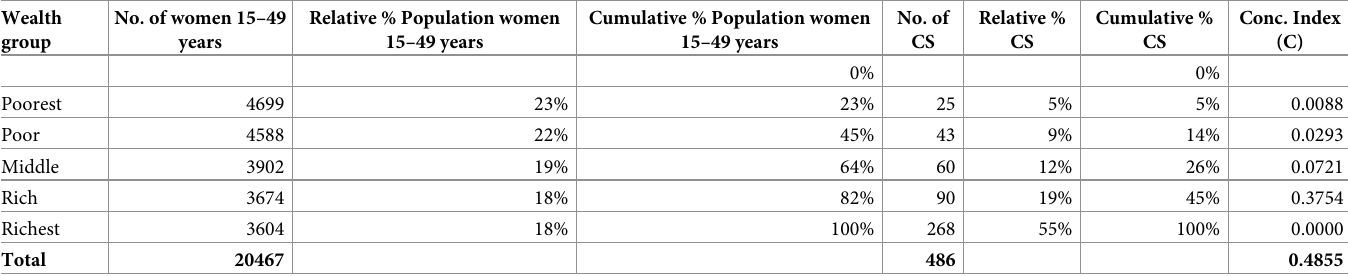
Table 2. Caesarean delivery and concentration index for inequality among women in Nigeria. Wealth